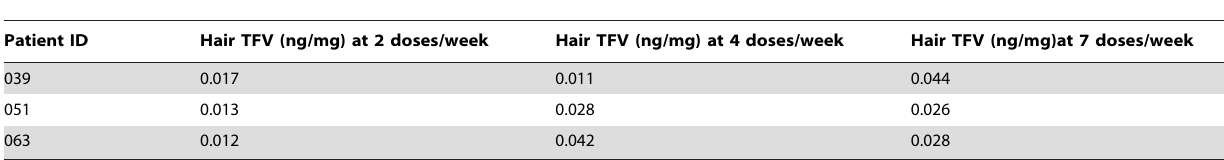
Table 3. Three participants where hair levels did not demonstrate monotonic